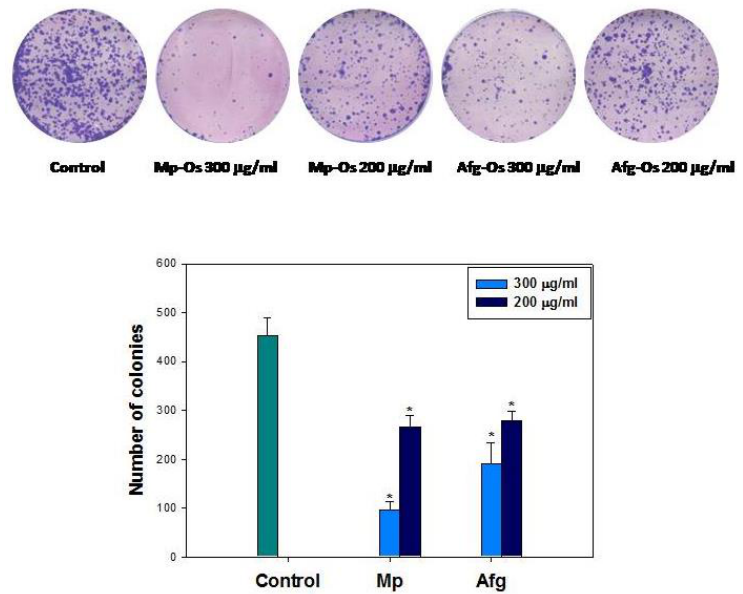
Figure 4. Colony images under different treatments. Oligosaccharides Mp-OS and Afg-OS reduced number of HCT-116 cell colonies in a dose-dependent manner. ImageJ 1.52 software was used to count the cell colonies. Data are presented as means ± SEM. * p value < 0.05 considered significant.